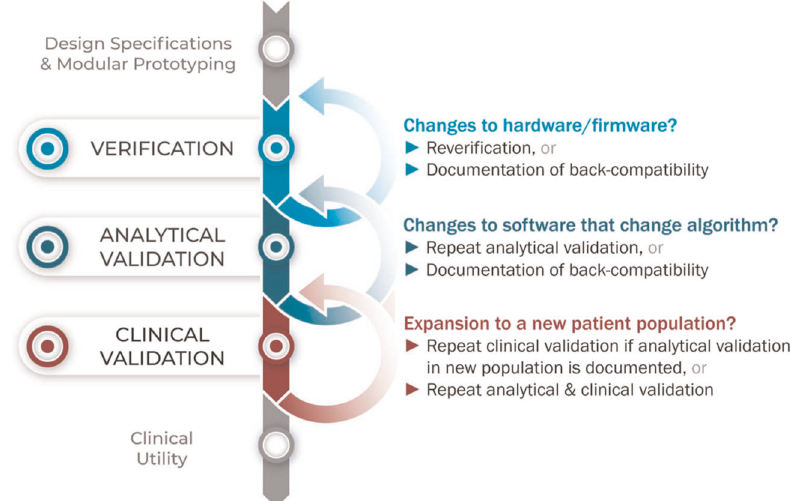
Fig. 3 V3 in practice: The veri fi cation, analytical validation, and clinical validation process in the real world. The V3 process in practice.